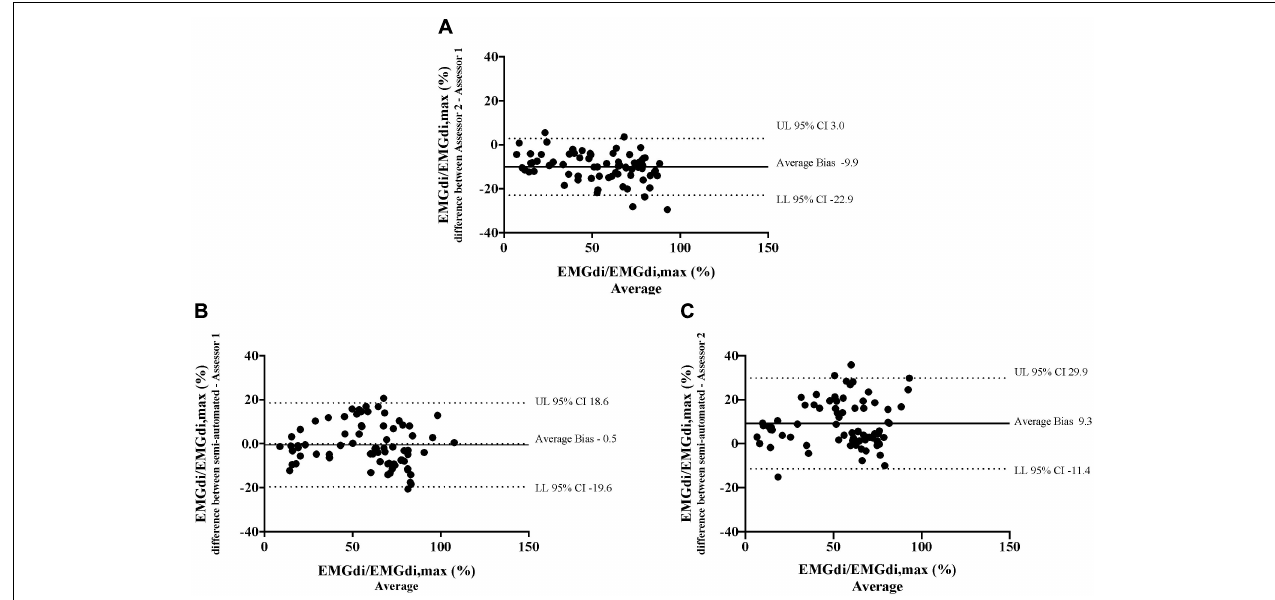
FIGURE 5 | The results from the manual method by two assessors and the semi-automated method are compared in seven patients in each minute during the pre-measurement CWR cycling test. Bland-Altman plots of EMGdi/EMGdiMax% calculated from the manual method by two assessors (A) ; the semi-automated method and the manual method by assessor 1 (B) ; the semi-automated method and the manual method by assessor 2 (C) .